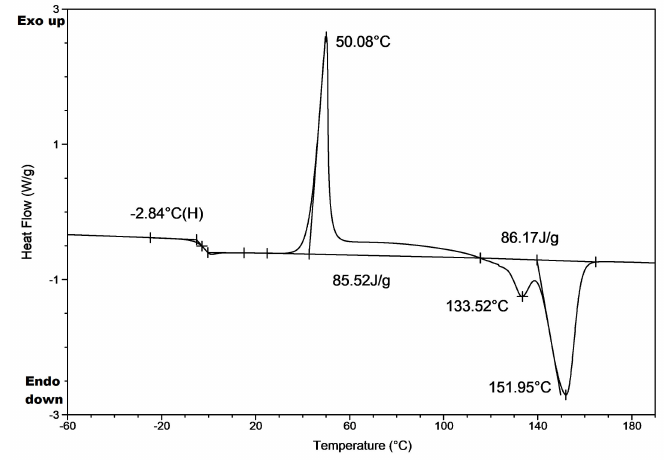
Figure 5. DSC heating trace obtained after rapid cooling from 200 ◦ C, for PHA 3 sample residues remaining after 9 months of hydrolytic